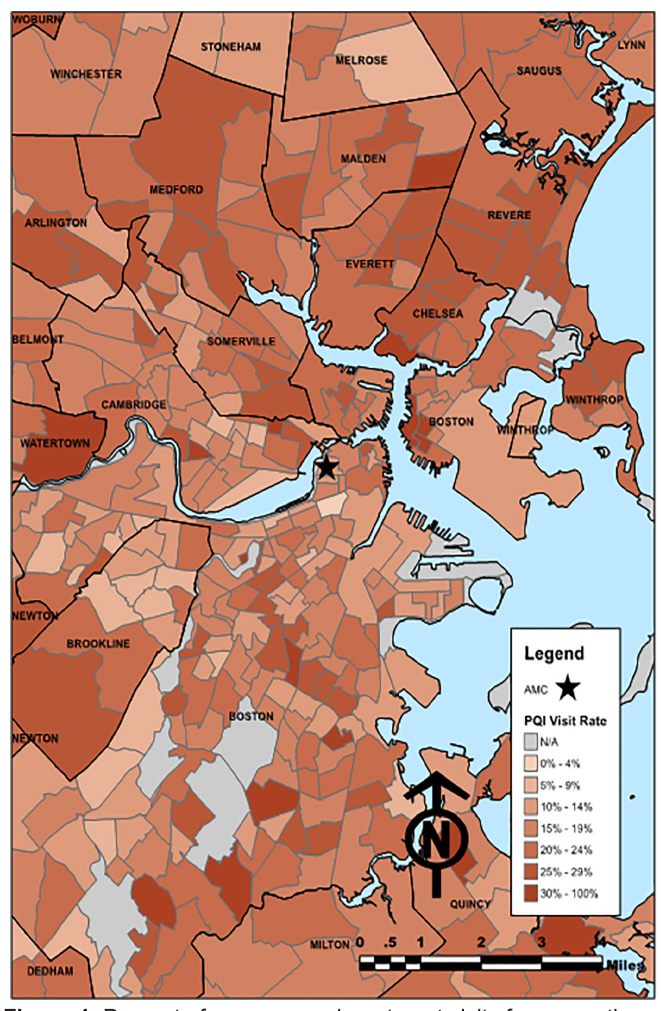
Figure 1. Percent of emergency department visits for prevention quality indicator conditions by census